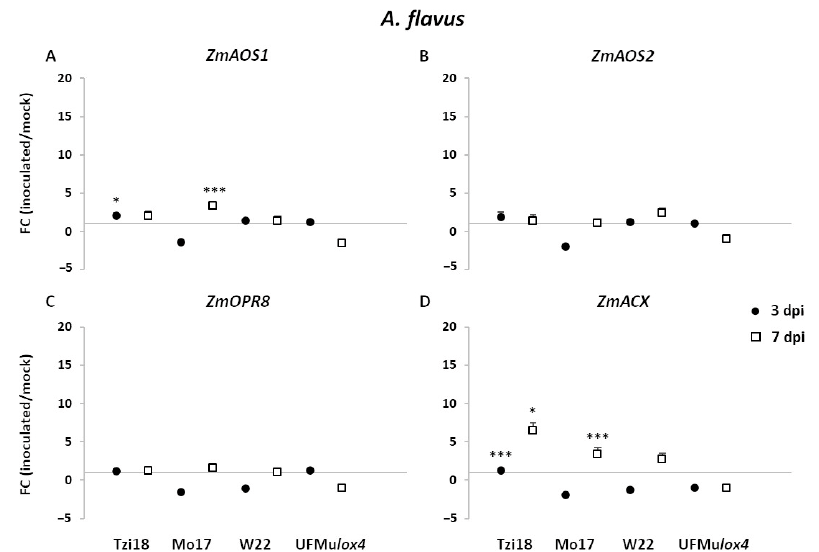
Figure 9. RT-qPCR analysis of maize oxylipin- and JA-related genes upon A. flavus inoculation. Fold change (FC) of expression between inoculated and mock kernels of Tzi18, Mo17, W22, and UFMu lox4 lines at 3 (circle) and 7 (square) dpi with A. flavus . ( A ) ZmAOS1 , ( B ) ZmAOS2 , ( C ) ZmOPR8 , and ( D ) ZmACX . Vertical bars indicate the standard error. Asterisk denotes significant upregulation/downregulation with 2-fold or higher FC using Welch’s t-test (* p ≤ 0.05; *** p ≤ 0.001).